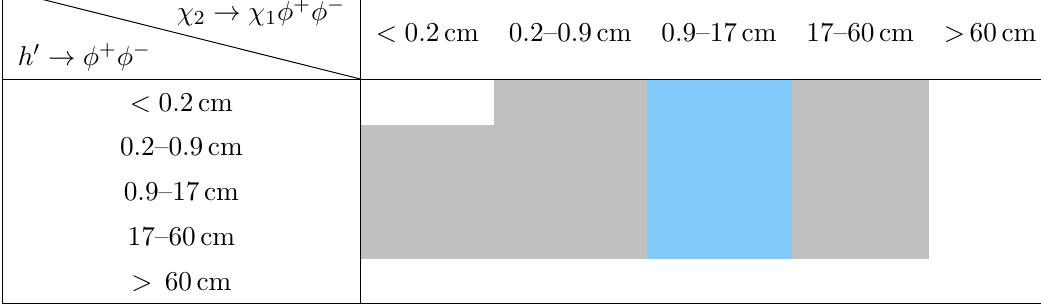
final states are considered, i.e. 2